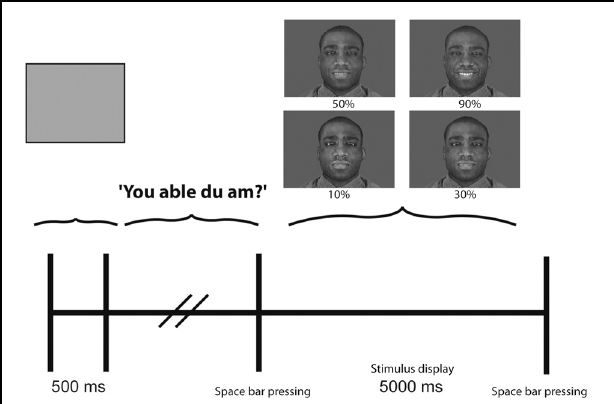
FIGURE 1 | Experimental paradigm. The protocol for each trial was the following: (1) Blank screen 500ms. (2) Appearance of the question “You able du am?” (Are you ready?) on screen until space bar pressed. (3) Stimulus presentation for 5000ms (random presentation of single faces expressing different emotions at different intensities). (4) After space bar pressing, trial cycle repeats (i.e., 500ms blank etc.). In the Movies experiment the experimental paradigm was exactly the same with the only difference that the stimulus presentation lasted